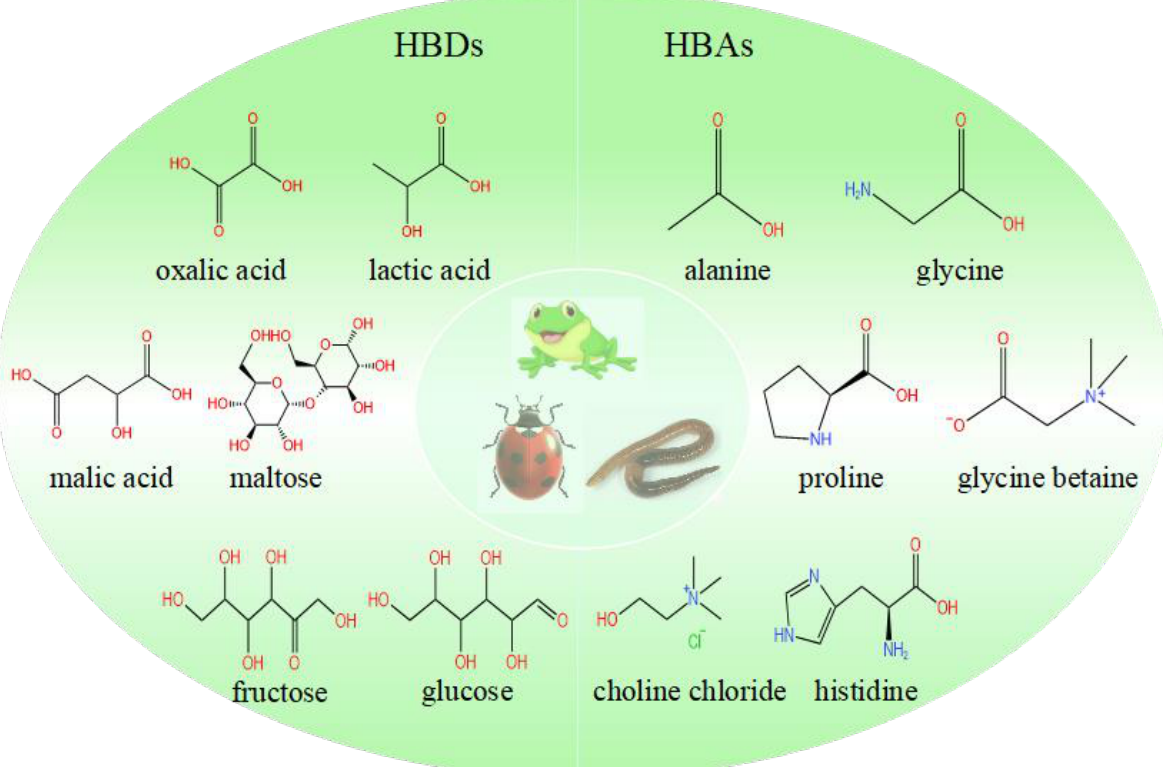
Figure 1. Chemical structures of common HBDs and HBAs.